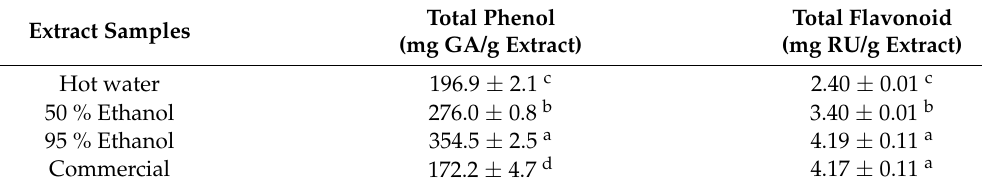
Table 1. Total phenol and flavonoid content of Phyllanthus emblica L. fruit extracts. Extract